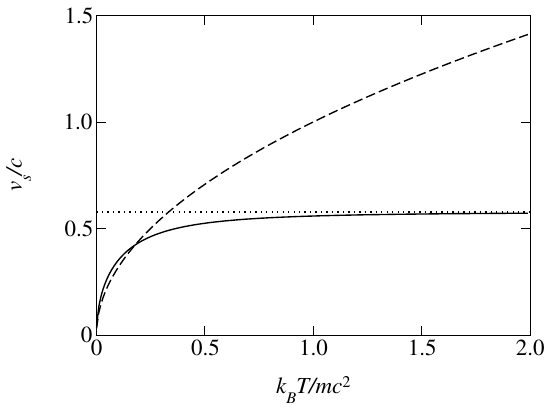
Fig. 11. Normalized sound velocity as a function of normalized tem- perature µ − 1 = k B T/mc 2 . Dashed line: classical result ( f = 1 ), (cid:112) v s /c = µ − 1 . Solid line: relativistic result [see Eq. (63)]. The hor- izontal dotted line represents the limit value 1 /